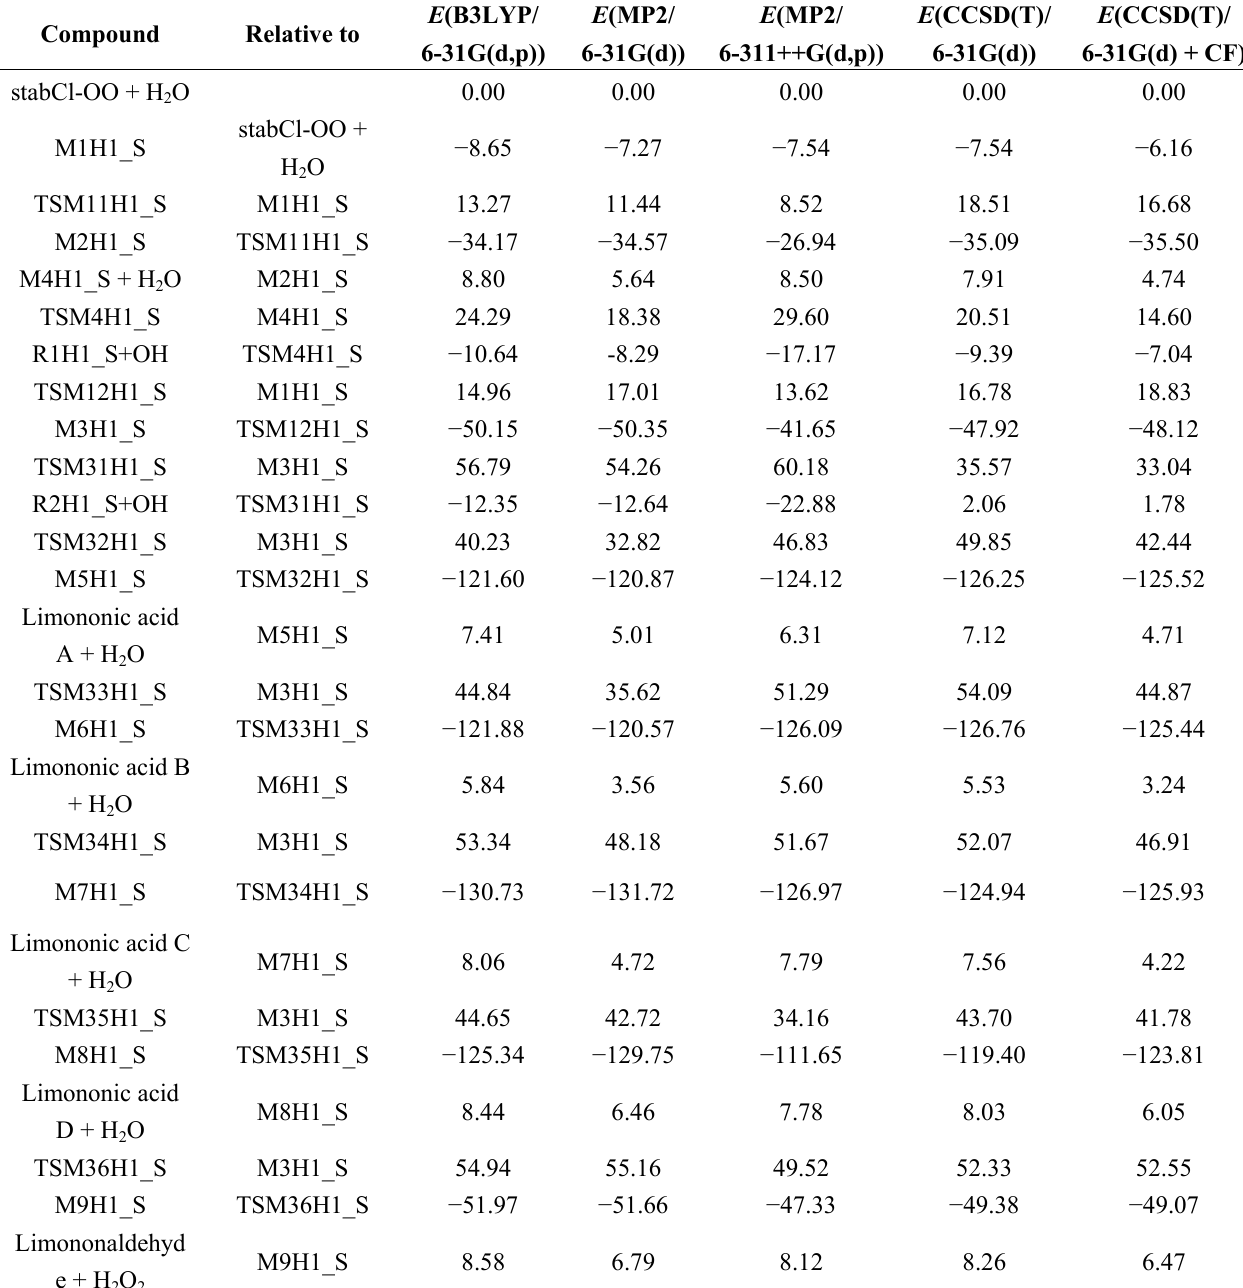
Table 1. Reaction and activation energies ( E ) with Zero-Point Correction (ZPE) included (kcal mol − 1 )) for the reaction between stabCl-OO and H